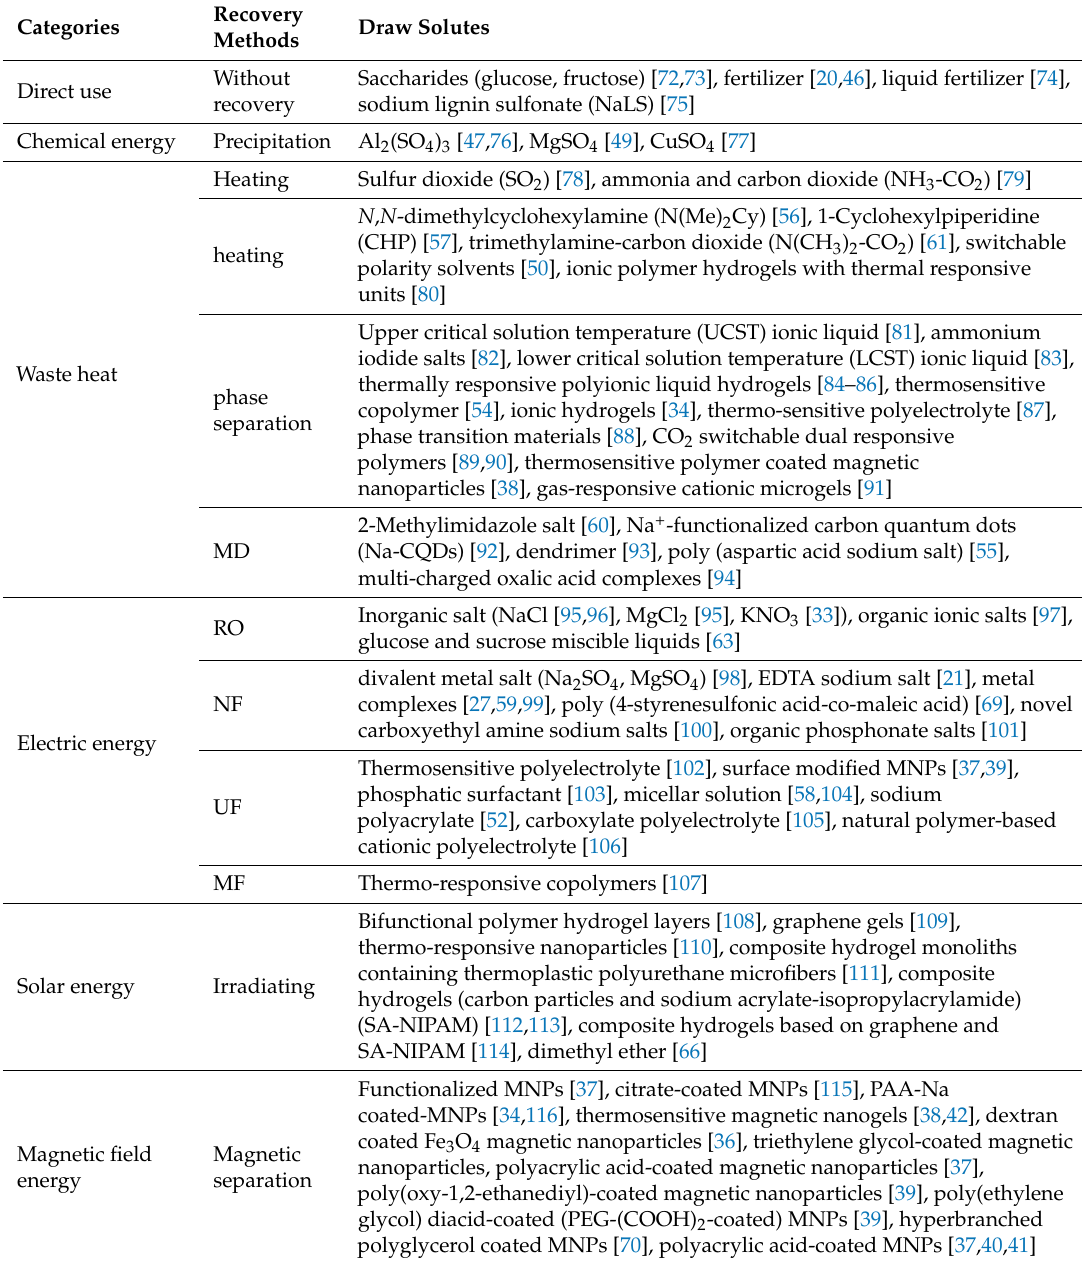
Table 2. Overview of DSs based on the types of energy used in recovery